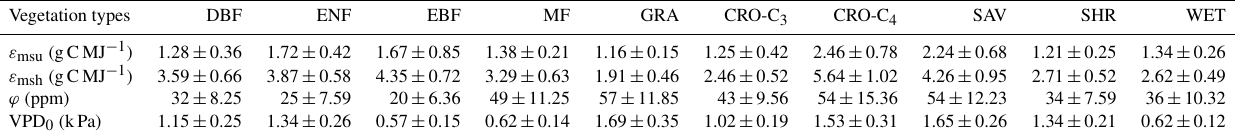
Table 3. Optimized parameters ( ε msu , ε msh , ϕ , and VPD 0 ) of the revised EC-LUE model for different vegetation types. Vegetation types